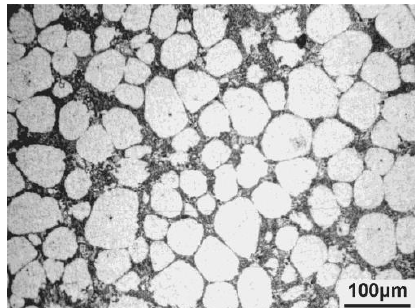
Figure 4. OM image of the A356 matrix alloy.